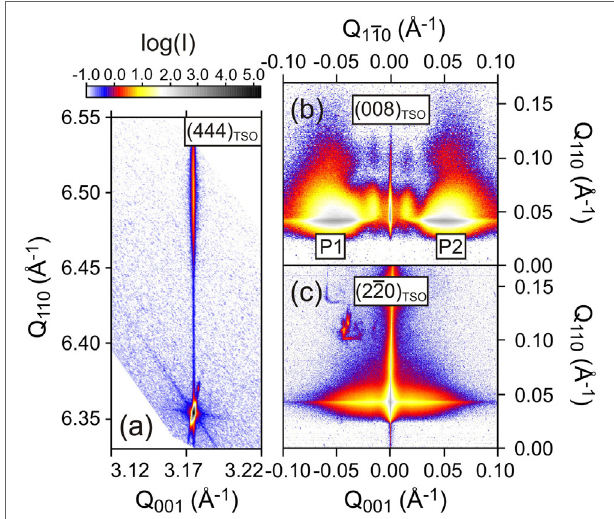
FigUre 5 | (a) X-ray reciprocal space maps around the (444) TSO substrate Bragg reflection. Grazing incidence in-plane X-ray diffraction map in the vicinity of (008) TSO (b) and (220) TSO (c) substrate Bragg